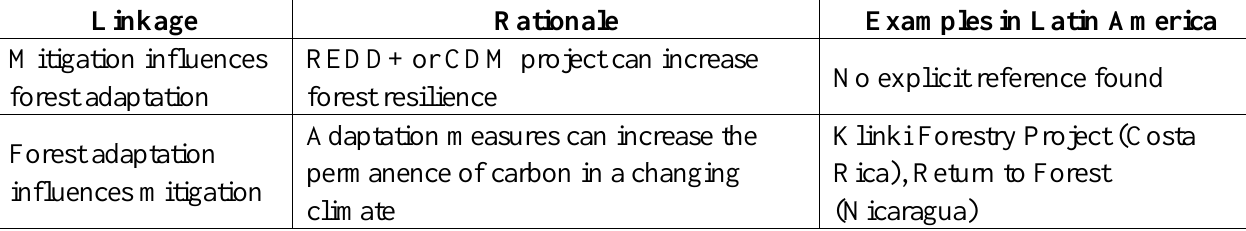
Table 4. Linkages between mitigation and forest